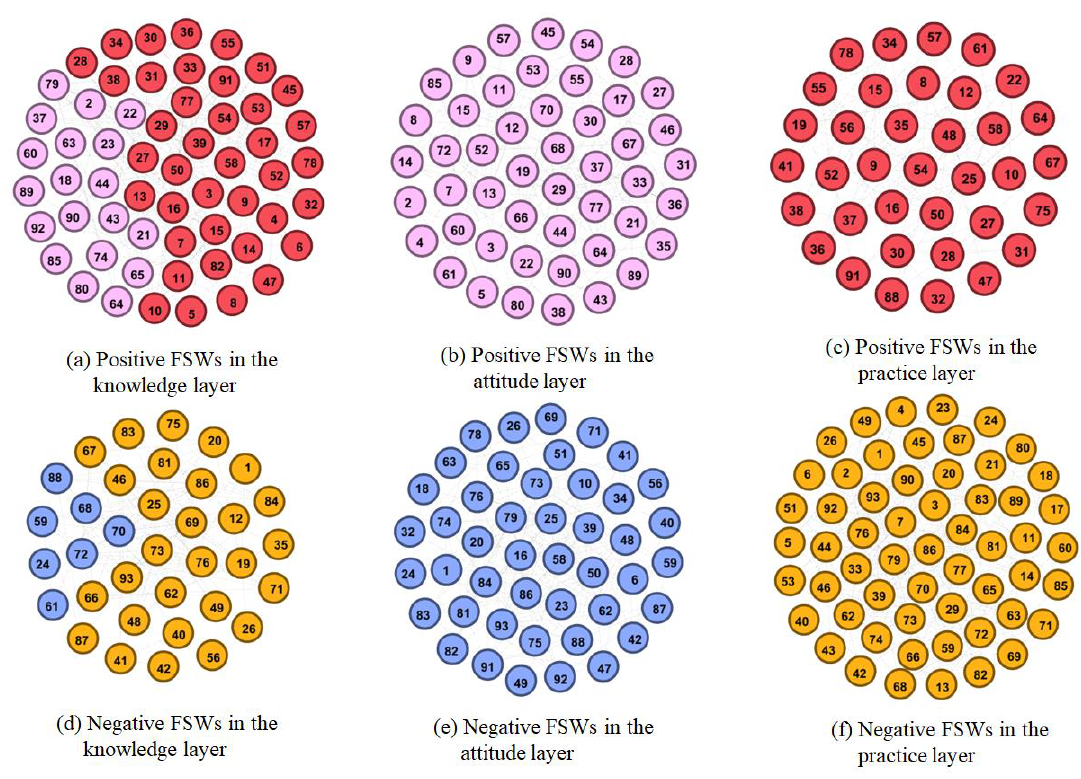
Figure 6. Positive or negative effects of neighbors. ( a – c ) Represent the positive sub-network in the KAP layers. Red nodes are positively influenced by neighbors in the same layer, while purple nodes are negatively influenced. ( d – f ) Represents the negative sub-network, with orange indicating the node is positively influenced by neighbors and blue the opposite.